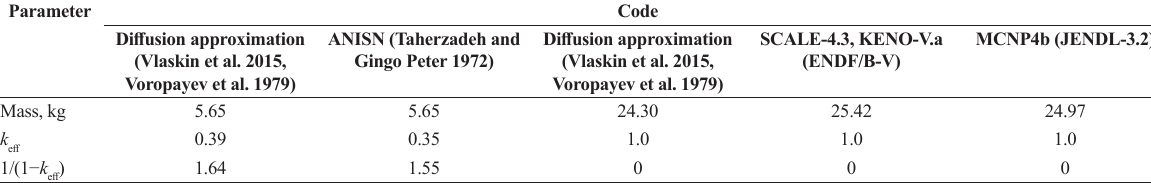
fuel composition. 2